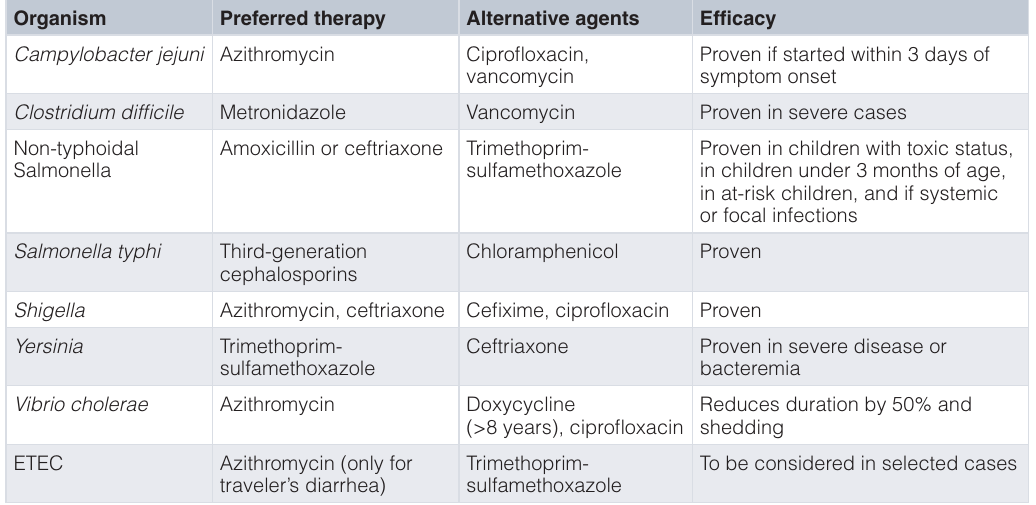
Table 3. Antibiotic choice based on